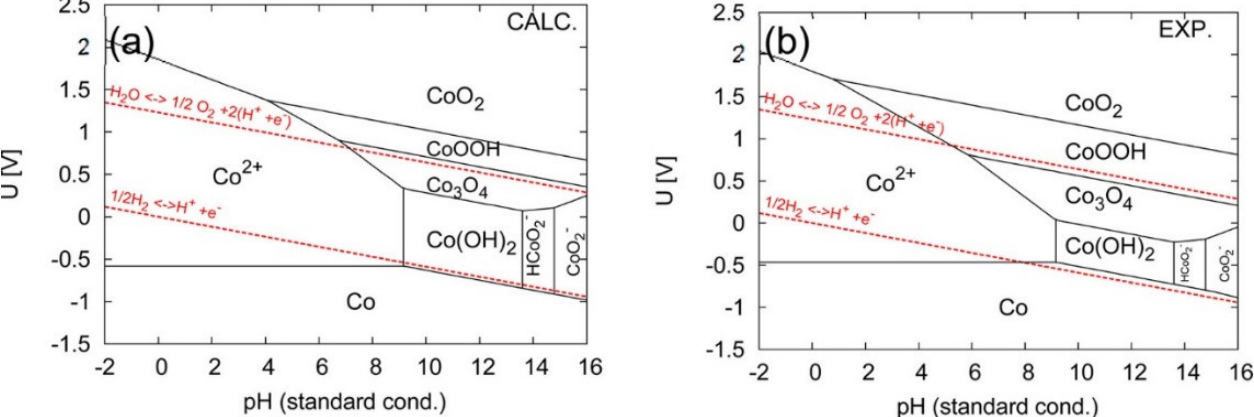
Figure 22. Pourbaix diagrams of bulk phases based on ( a ) the calculated formation free energies of solid compounds and the corrected experimental free energies of aqueous ionsand ( b ) based only on experimental formation free energies. (Reprinted from ref. [68] with permission from Journal of American Chemical Society. Copyright © 2013, American Chemical Society).